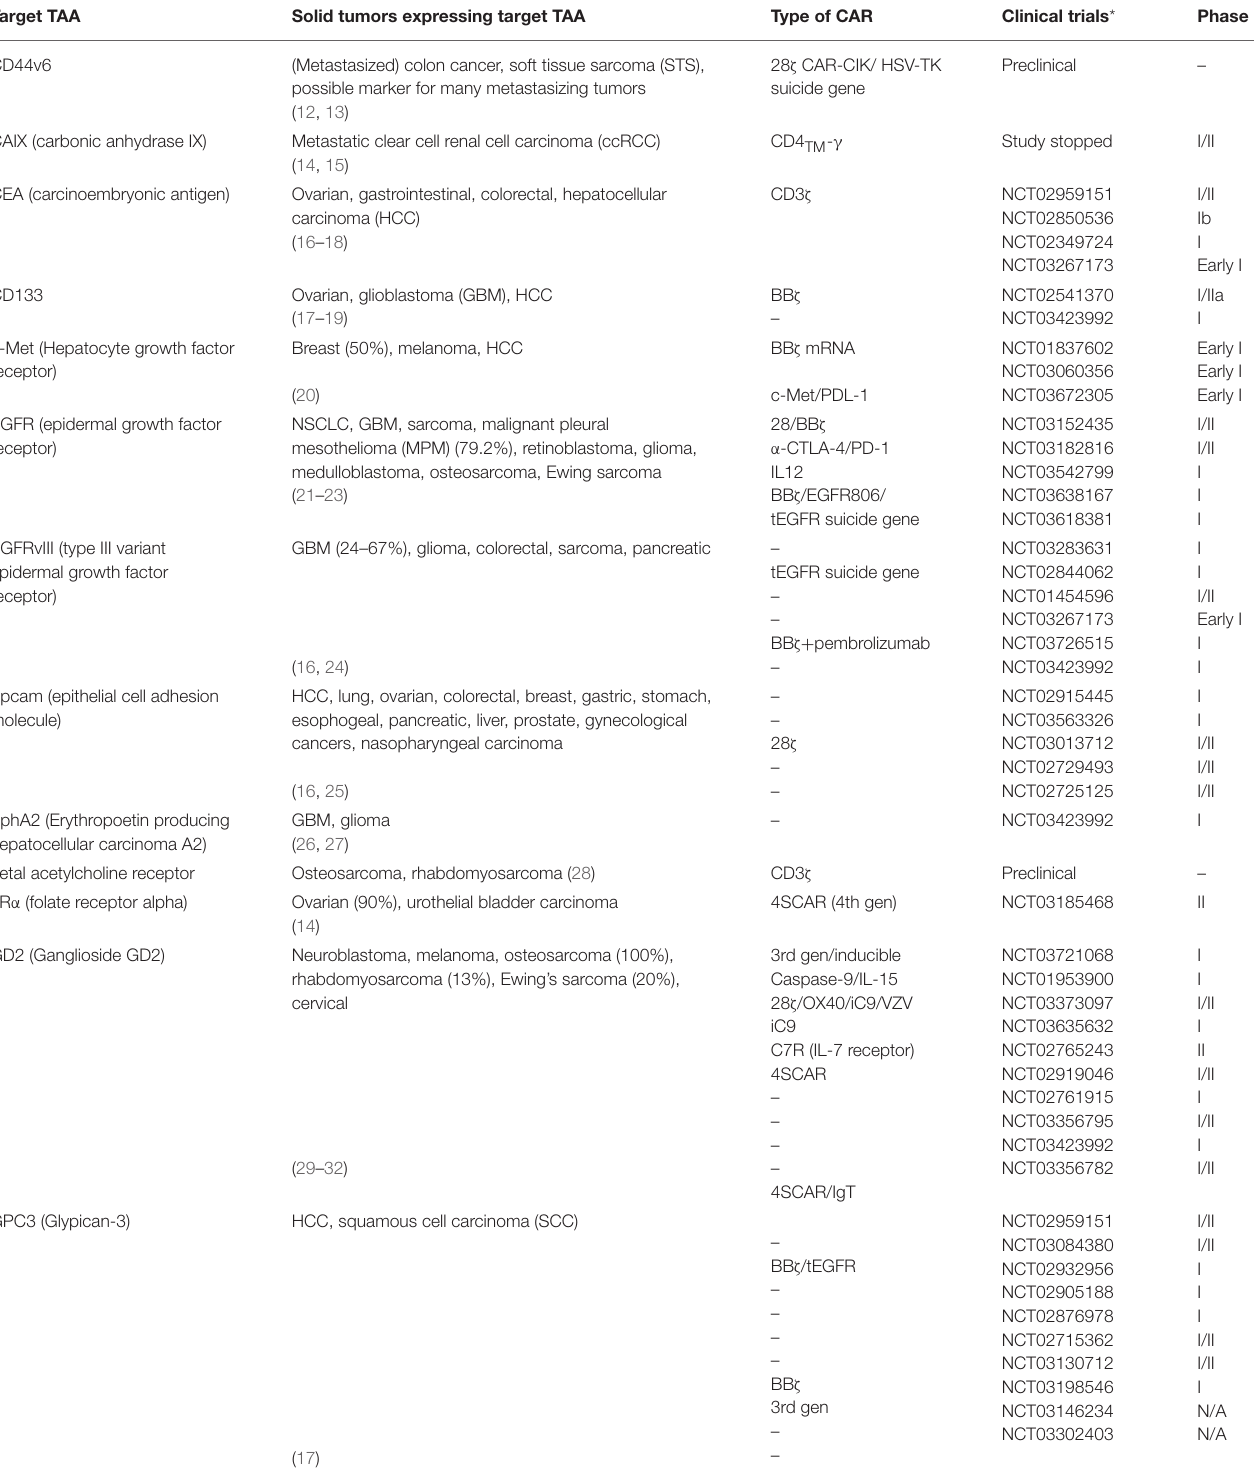
TABLE 1 | Common solid tumor associated target antigens, most recent CAR constructs, and the stage of testing they have reached. Target